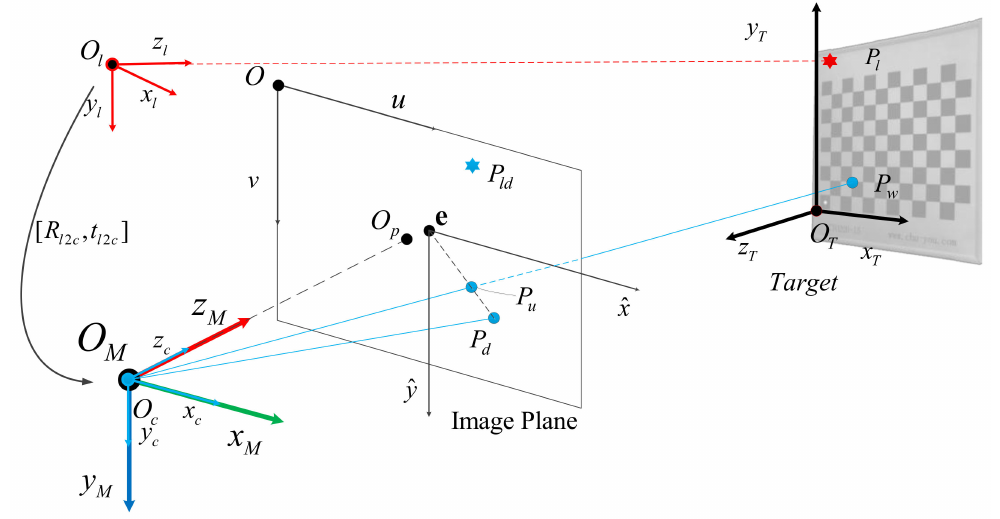
Figure 1. Measurement